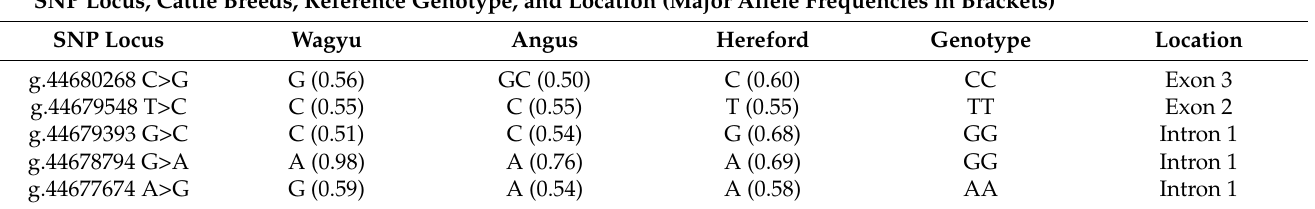
Table 4. FABP4 gene SNP in Bowen Genetics Forest Pastoral Angus, Hereford, and Wagyu beef cattle. SNP Locus, Cattle Breeds, Reference Genotype, and Location (Major Allele Frequencies in